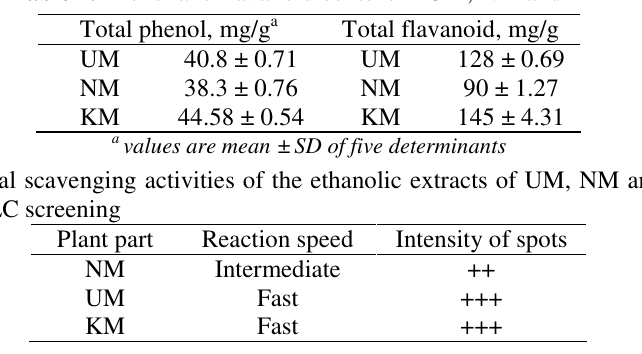
Table 2. Phenol and flavanoid content in UM, NM and KM